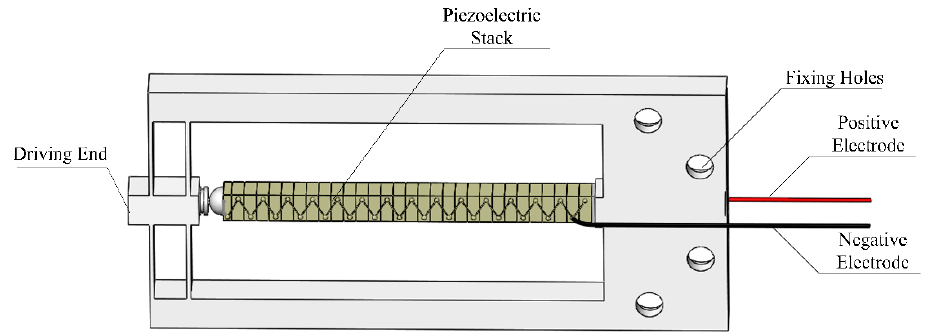
Figure 1. Structure of the piezoelectric actuator.